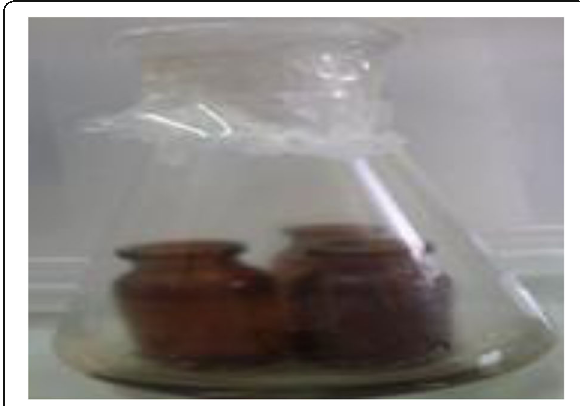
Fig. 1 Sterilization of bacteria and algae supernatant by vapor of